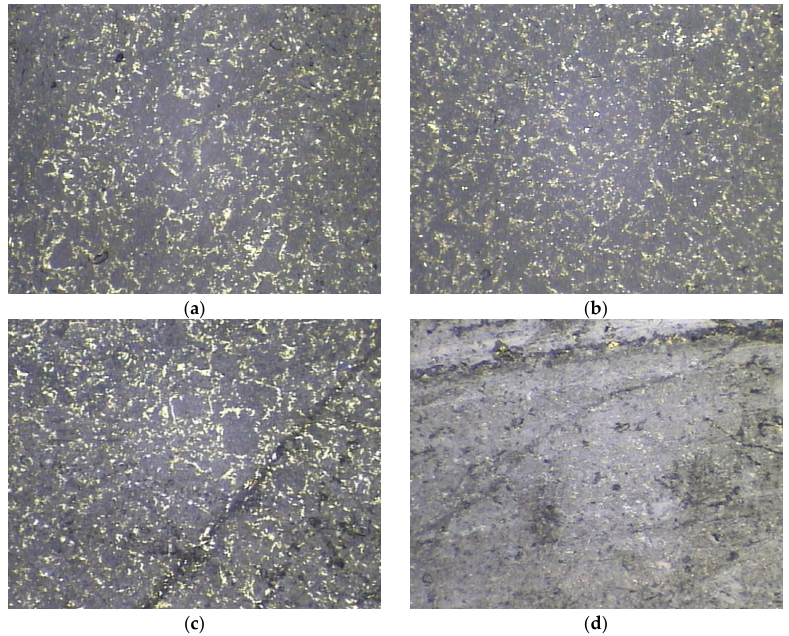
Figure 12. Surface appearance of the auxiliary sealing surface of the floating-ring test piece. ( a ) The air-inlet direction is the same as the spindle-rotation direction primary floating ring; ( b ) the air-inlet direction is the same as the spindle-rotation direction secondary floating ring; ( c ) the air-inlet di- rection is opposite to the spindle-rotation direction primary floating ring; ( d ) the air-inlet direction is opposite to the spindle-rotation direction secondary floating ring.